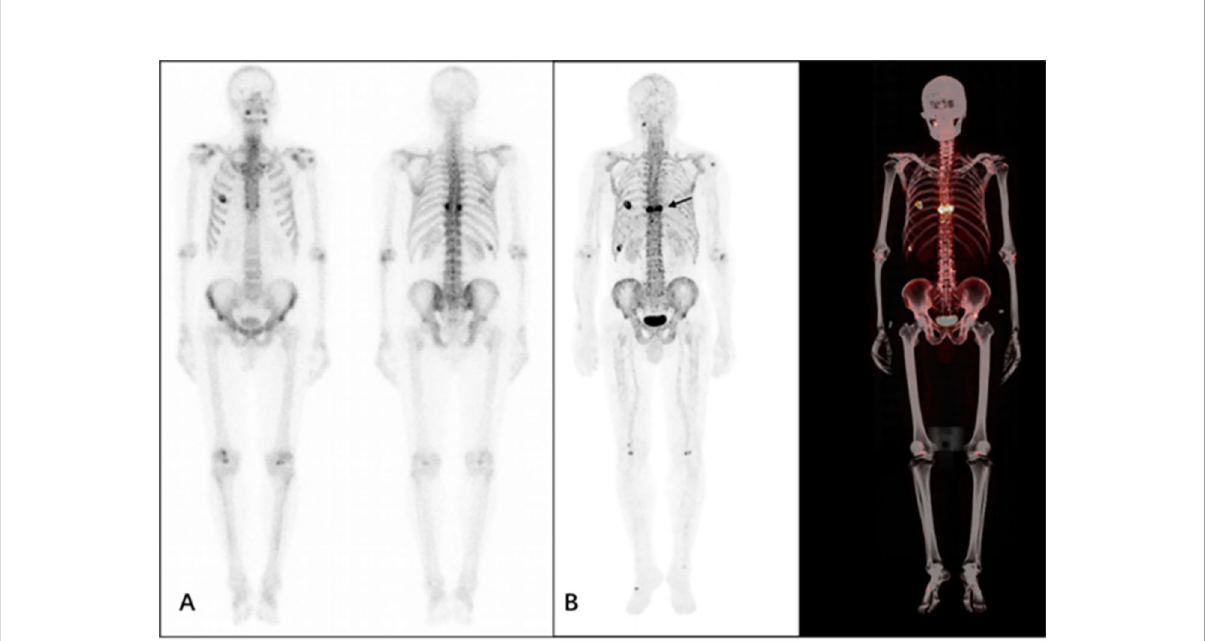
FIGURE 7 A 58-year-old male patient who underwent surgery for prostate cancer 2 months previously. The patient underwent 99m Tc-MDP (A) and 68 Ga- DOTA-IBA (B) imaging. From the MIP image, multiple foci of abnormal developer concentrations are visible in the thoracic spine and rib cage. The SUVmax of the lesion shown is approximately 7.8, T/NT 5.8 (arrow).